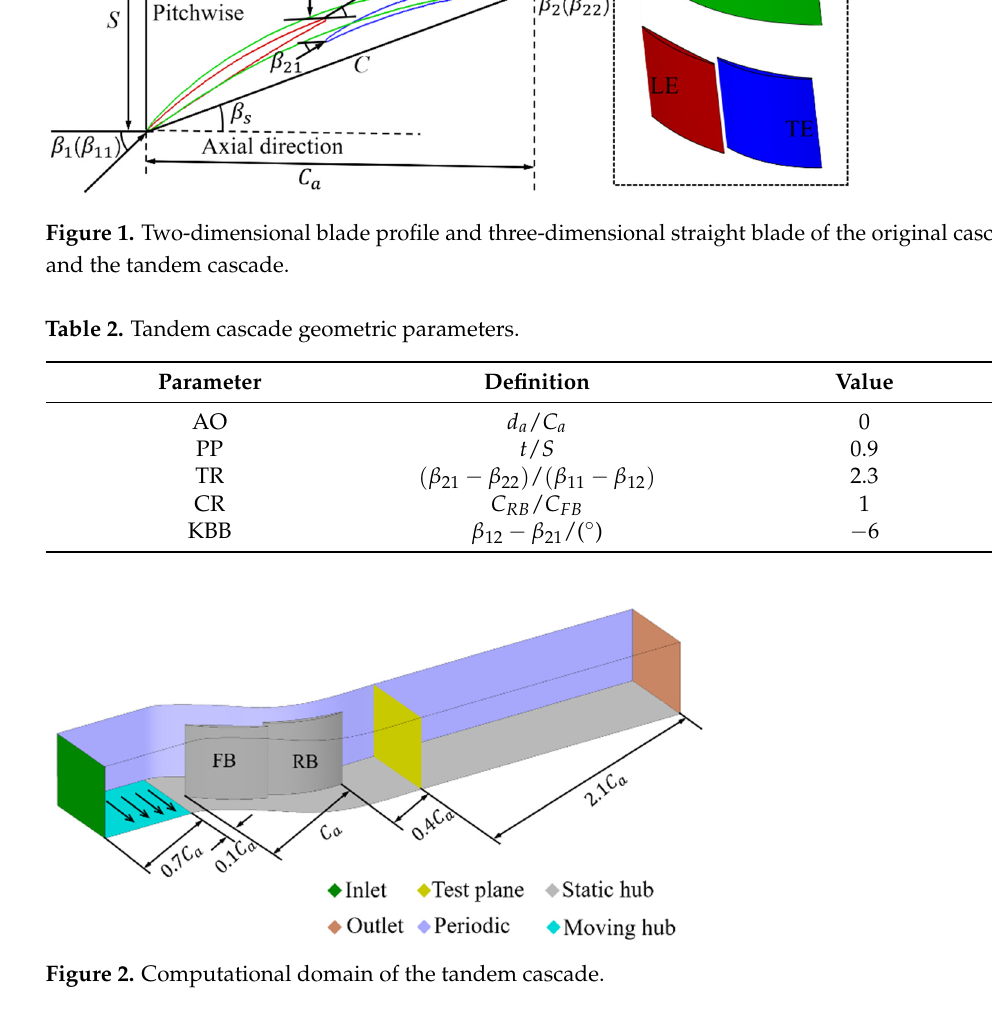
( b ) Figure 3. Numerical simulation of IBL thickness and skew: ( a ) Inlet total pressure distributions; ( b ) Generation of boundary layer skew. In the present investigation, the structured multiblock O4H-type topological grids of the original cascade were automatically generated by the AutoGrid5 in NUMECA soft- ware. The tandem cascade grids were formed by periodically matching and connecting the O4H-type topological grids of the FB and RB, thereby ensuring that the grid orthogo- nality is greater than 10°. Additionally, we locally densify the blade surface and endwall meshes to meet the requirement that the 𝑦 (cid:2878) value near the wall is less than 1 in the SST k- ω turbulence model. Figure 4 shows the variation of 𝑀𝑎 (cid:2869) and the overall total pressure loss coefficient ( 𝜁 ) of the original and tandem cascades with different grid numbers for grid independence verification. The total pressure loss coefficient is defined as: 𝜁 (cid:3404) 𝑃 (cid:3047)(cid:2869) (cid:3398)𝑃 (cid:3047) 𝑃 (cid:3047)(cid:2869) (cid:3398) 𝑝 (cid:2869) (1) where the inlet total pressure, inlet static pressure, and local total pressure are represented by 𝑃 (cid:2930)(cid:2869) , 𝑝 (cid:2869) , and 𝑃 (cid:3047) , respectively. Under the premise of considering the computational cost